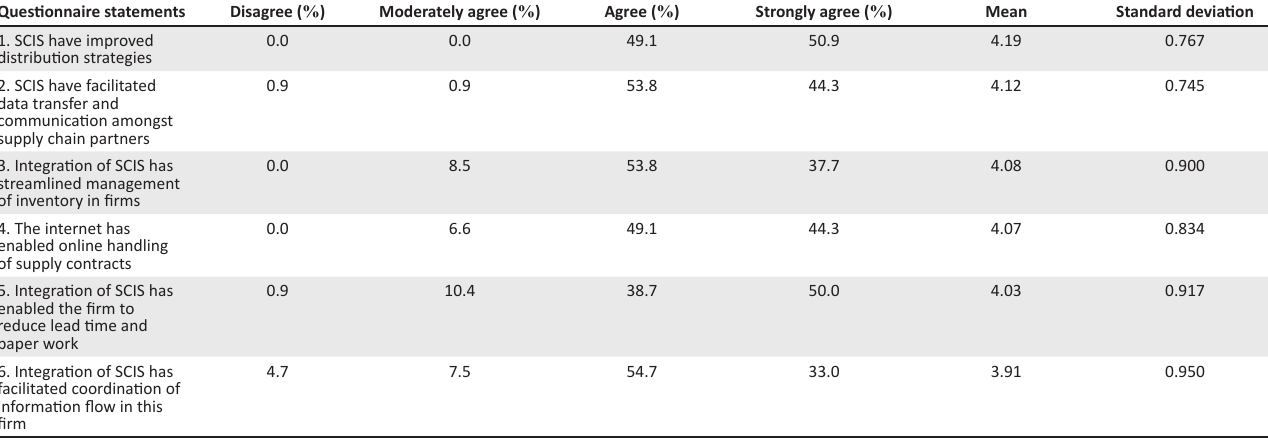
TABLE 3 : Benefits of supply chain information systems in the textile supply chain. Questionnaire statements